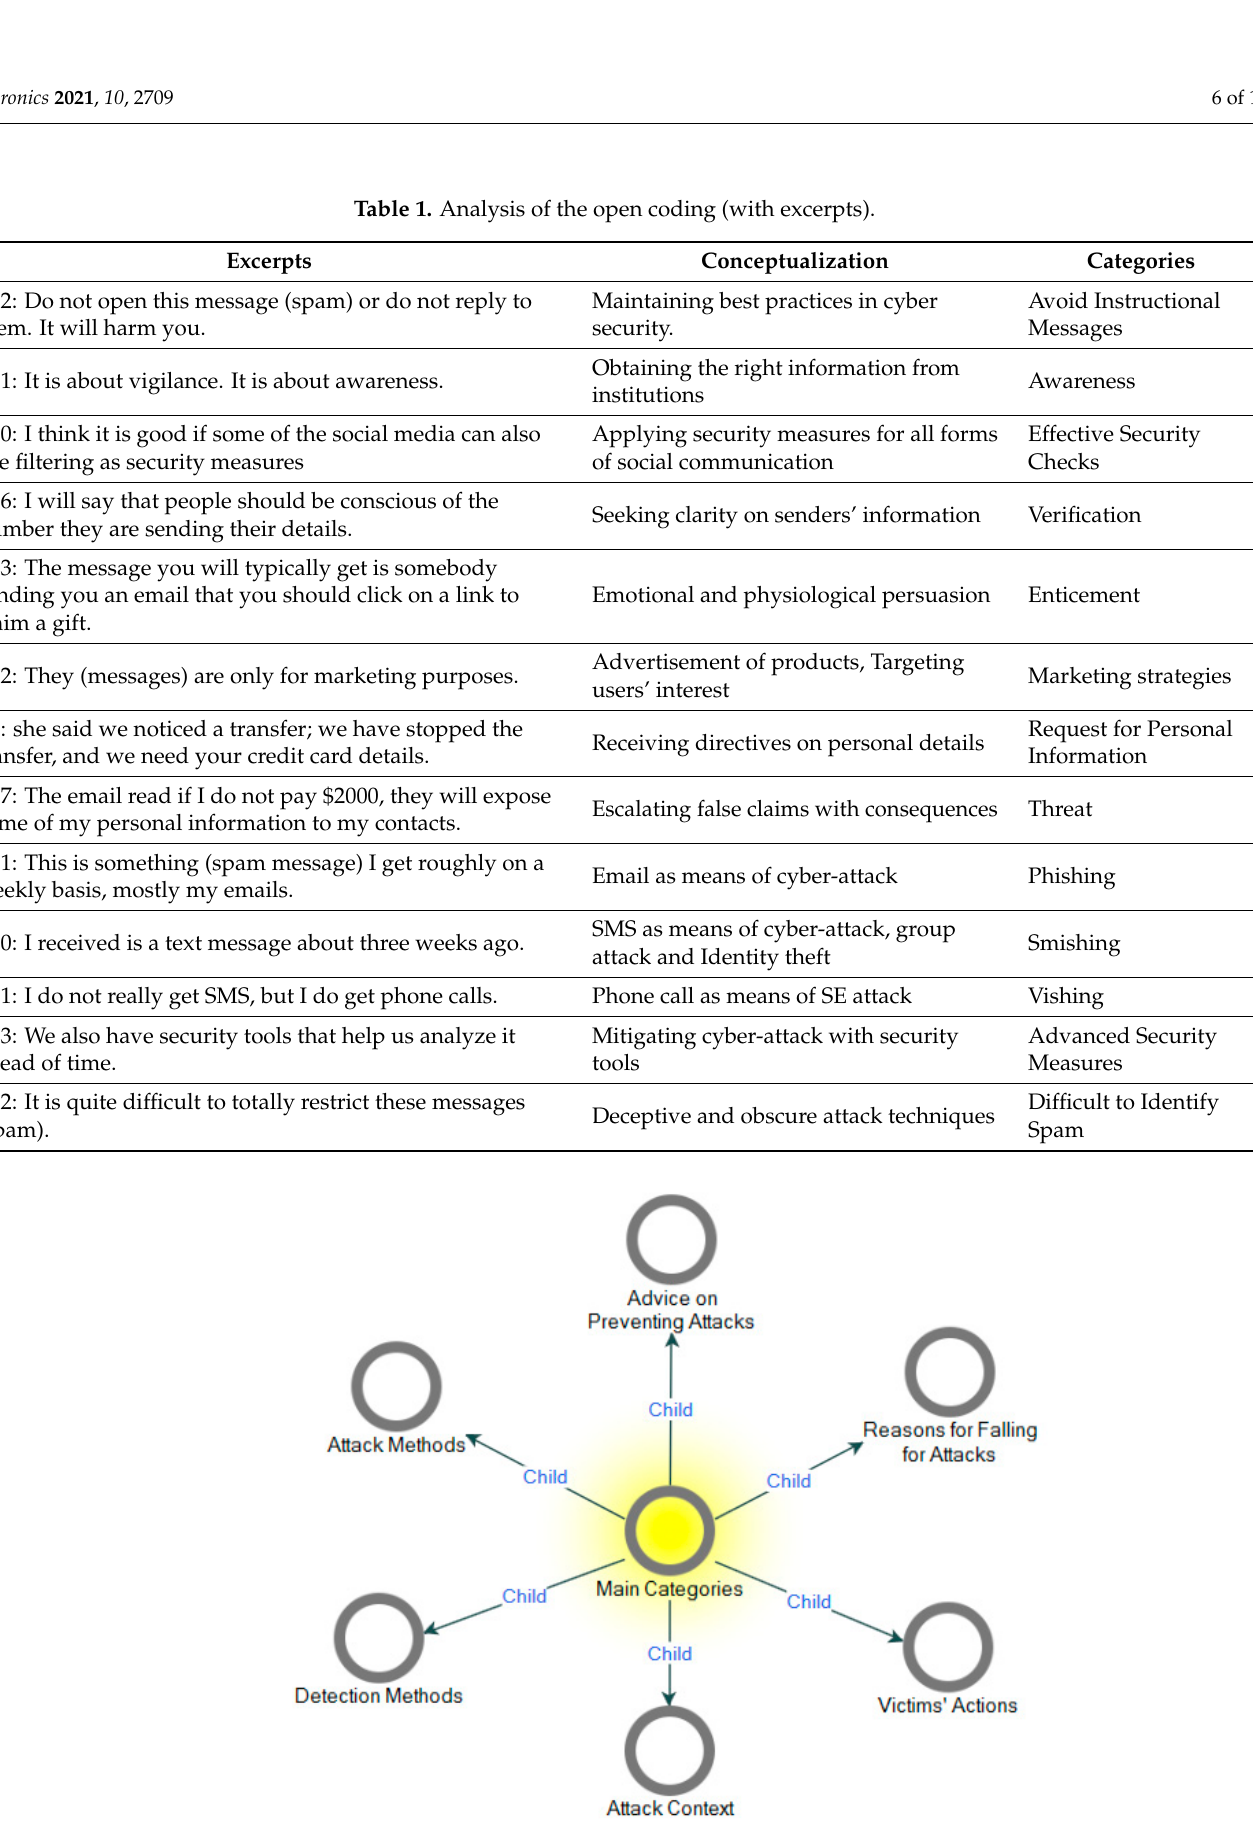
Figure 3. Main categories (Tree nodes).